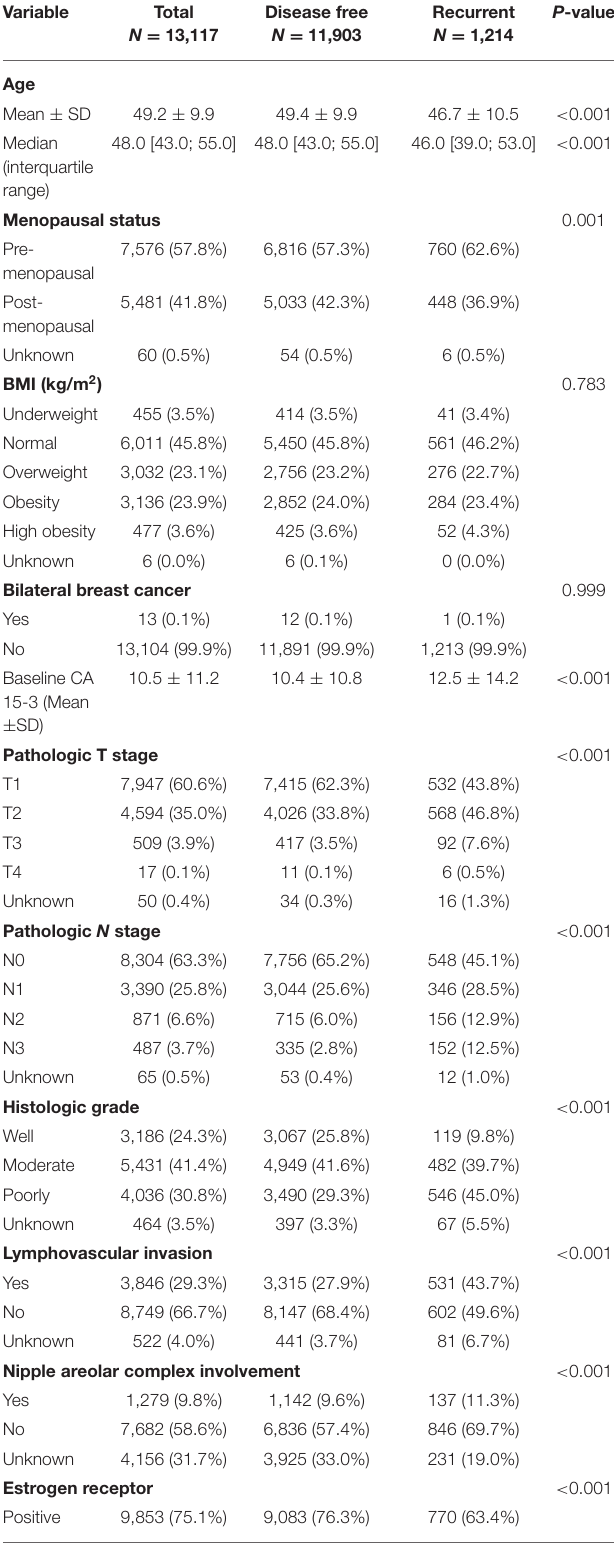
TABLE 1 | Characteristics of the study